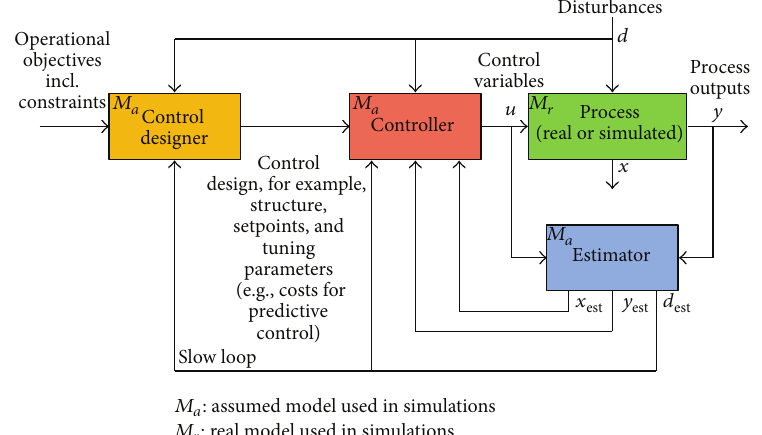
The symbol 𝑀 𝑎 in various blocks in Figure 2 represents the assumed mathematical model used in the block. The 𝑀 𝑟 symbol in the Process block is the model representing the real system (process). Only if model errors are assumed to be zero, 𝑀 𝑀 𝑎 and 𝑟 will be